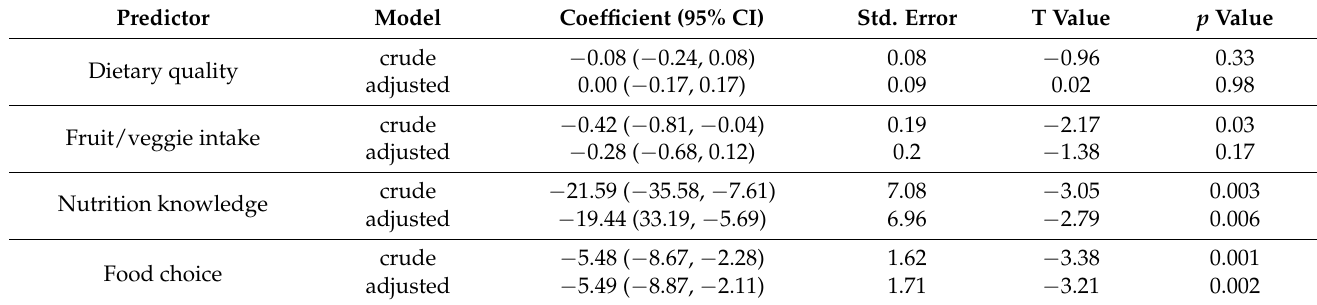
Table 5. Crude and adjusted regression models predicting weight change at 18